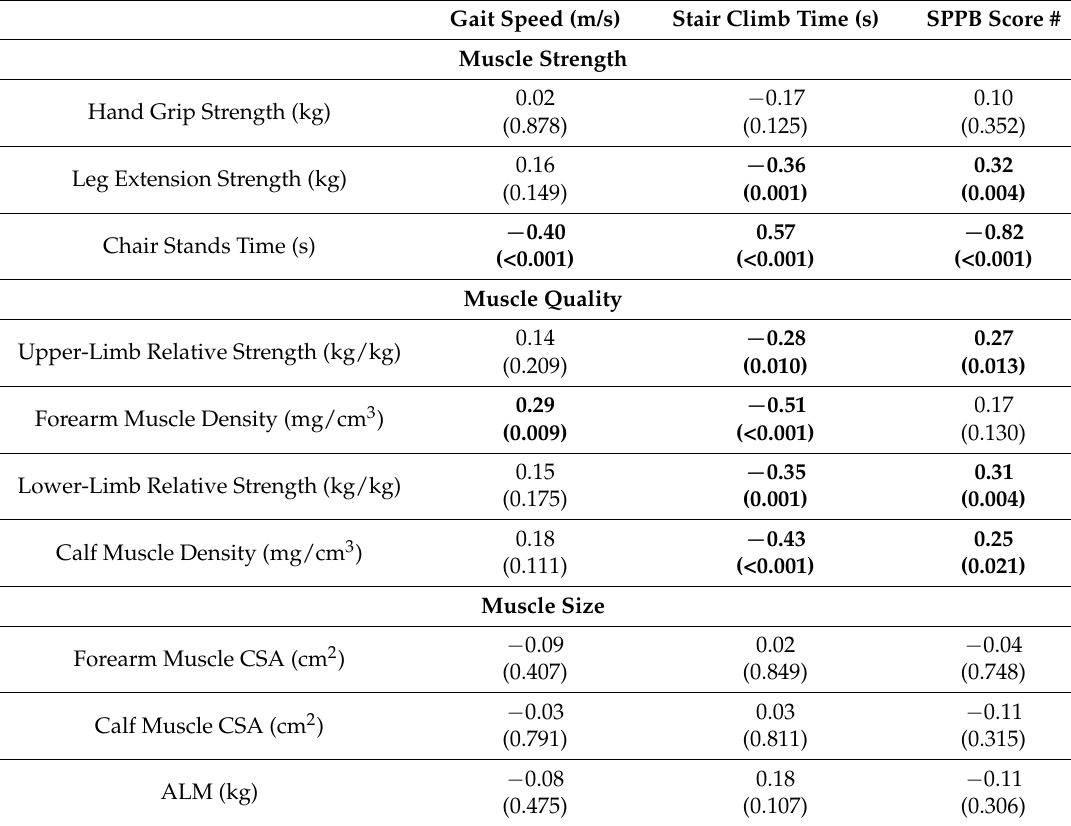
Table 2. Pearson’s correlation coefficients ( p -values) for measures of muscle strength, quality and size with physical performance.